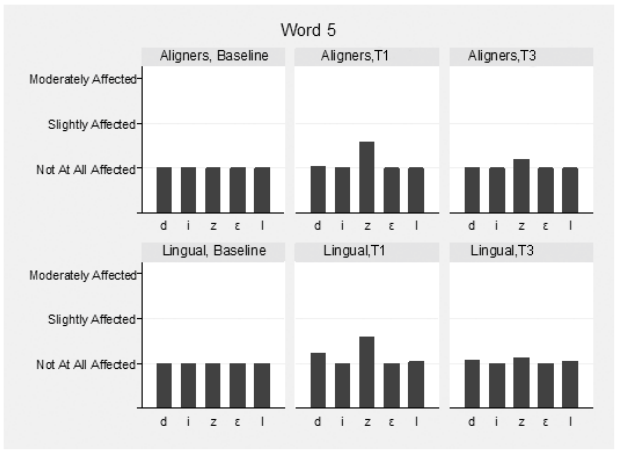
Figure 6. Speech articulation (5th word: “Diesel”) by group and time.